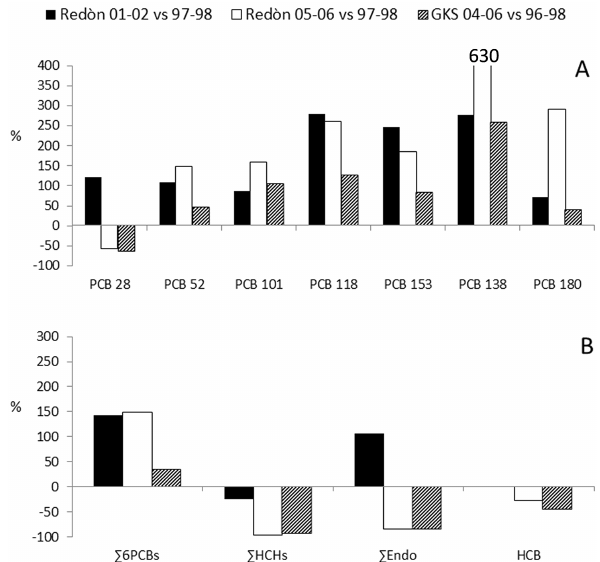
Figure 4. Percentage increase or decrease of atmospheric deposi- tion fluxes of individual PCB congeners (a) and OCs (b) at Redòn and Gossenköllesee (GKS) during the study